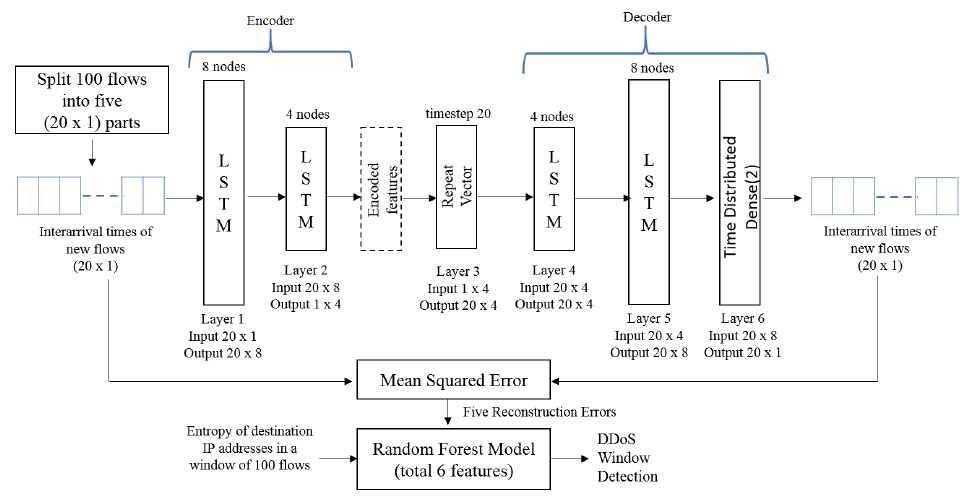
Figure 4. LSTM-RF hybrid